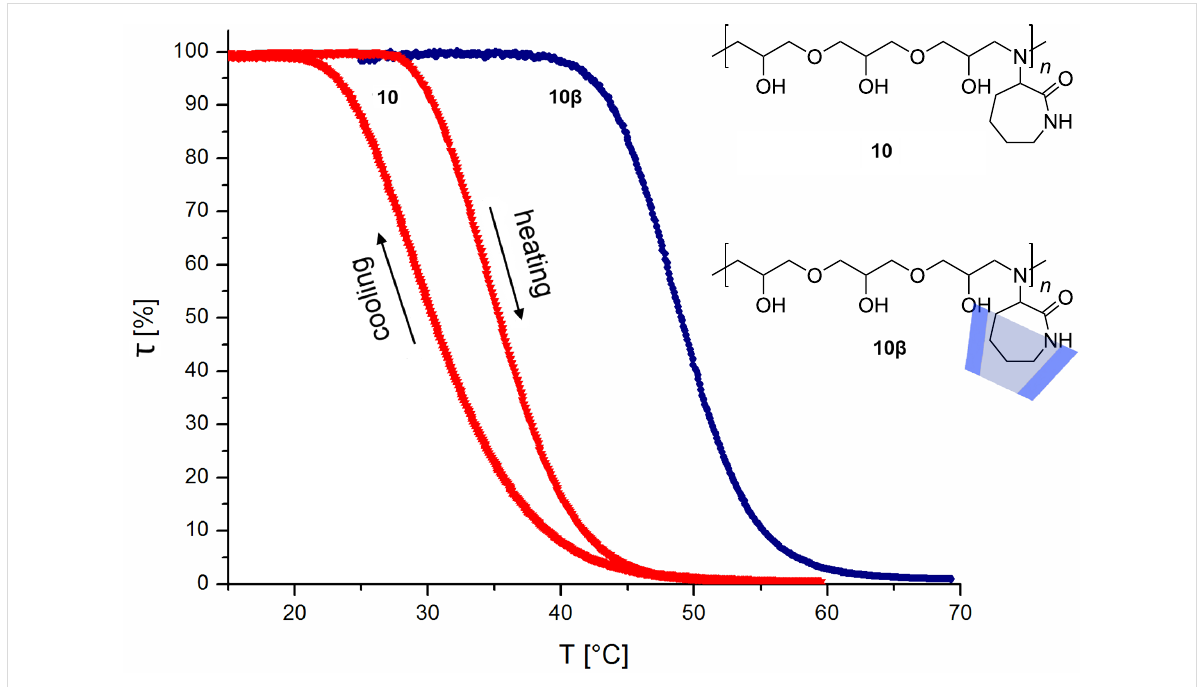
Figure 2: LCST measurements of 10 with illustrated heating and cooling curve, as well as the heating curve after addition of RAMEB-CD 10 β .